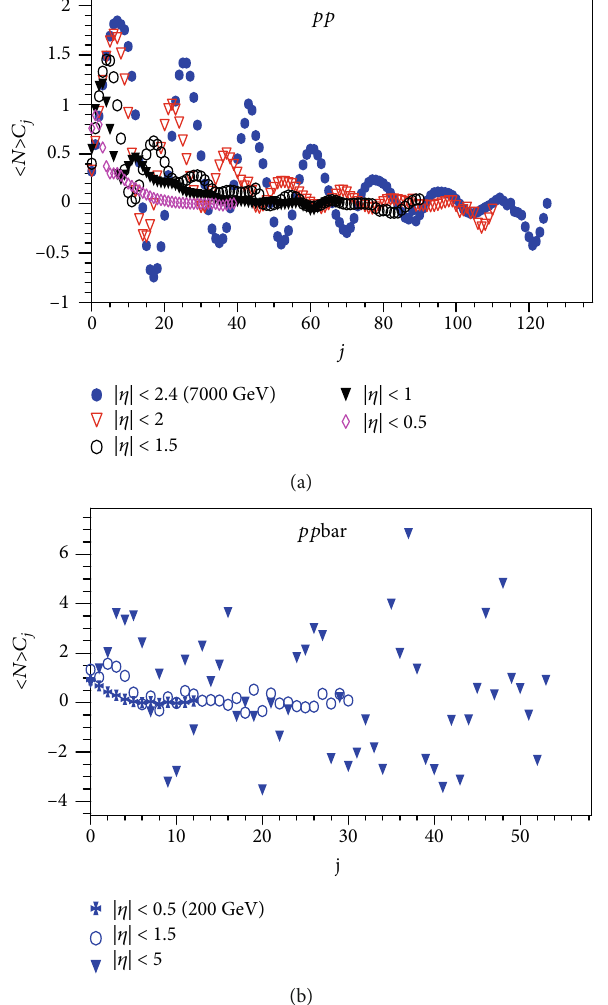
Figure 7: Coe ffi cients C obtained from the CMS data of pp ffiffi p j collisions at = 7000 GeV for di ff erent pseudorapidity windows s ffiffi p (a) and the UA5 data of p (cid:1) p collisions at = 200 GeV in di ff erent s pseudorapidity windows